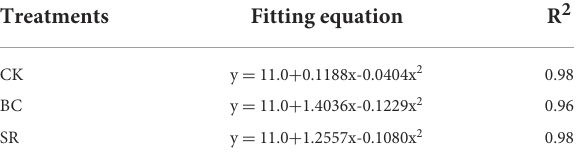
TABLE 8 The fitting equations in different